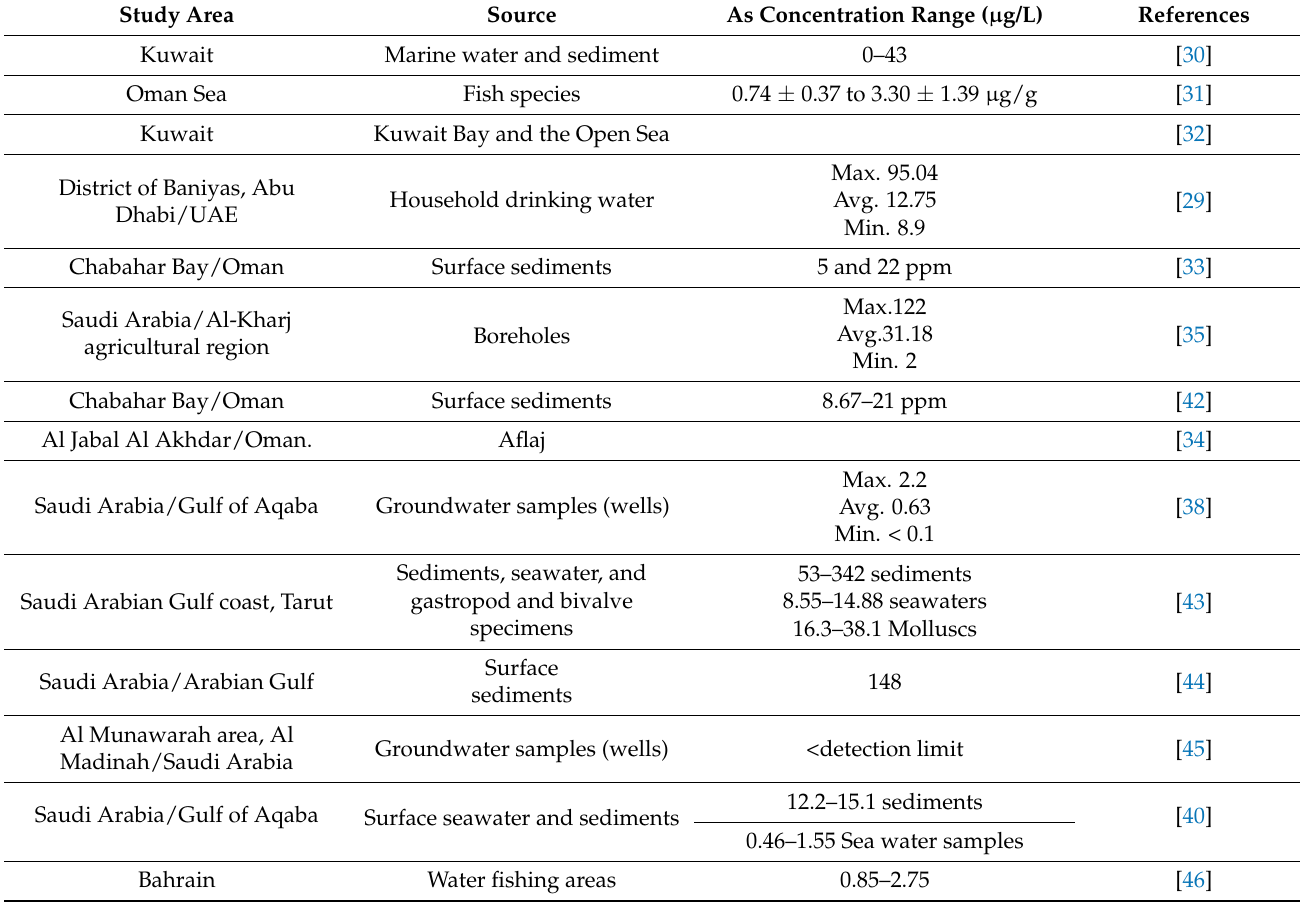
Table 2. Various concentrations of arsenic in the water of different Middle East